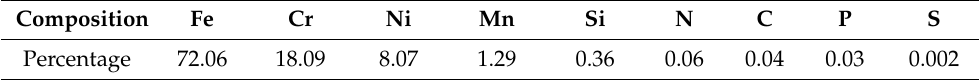
Table 1. Chemical compositions of SUS304. Table 2. Tensile properties of untreated and nanocrystallized 304 stainless steel.